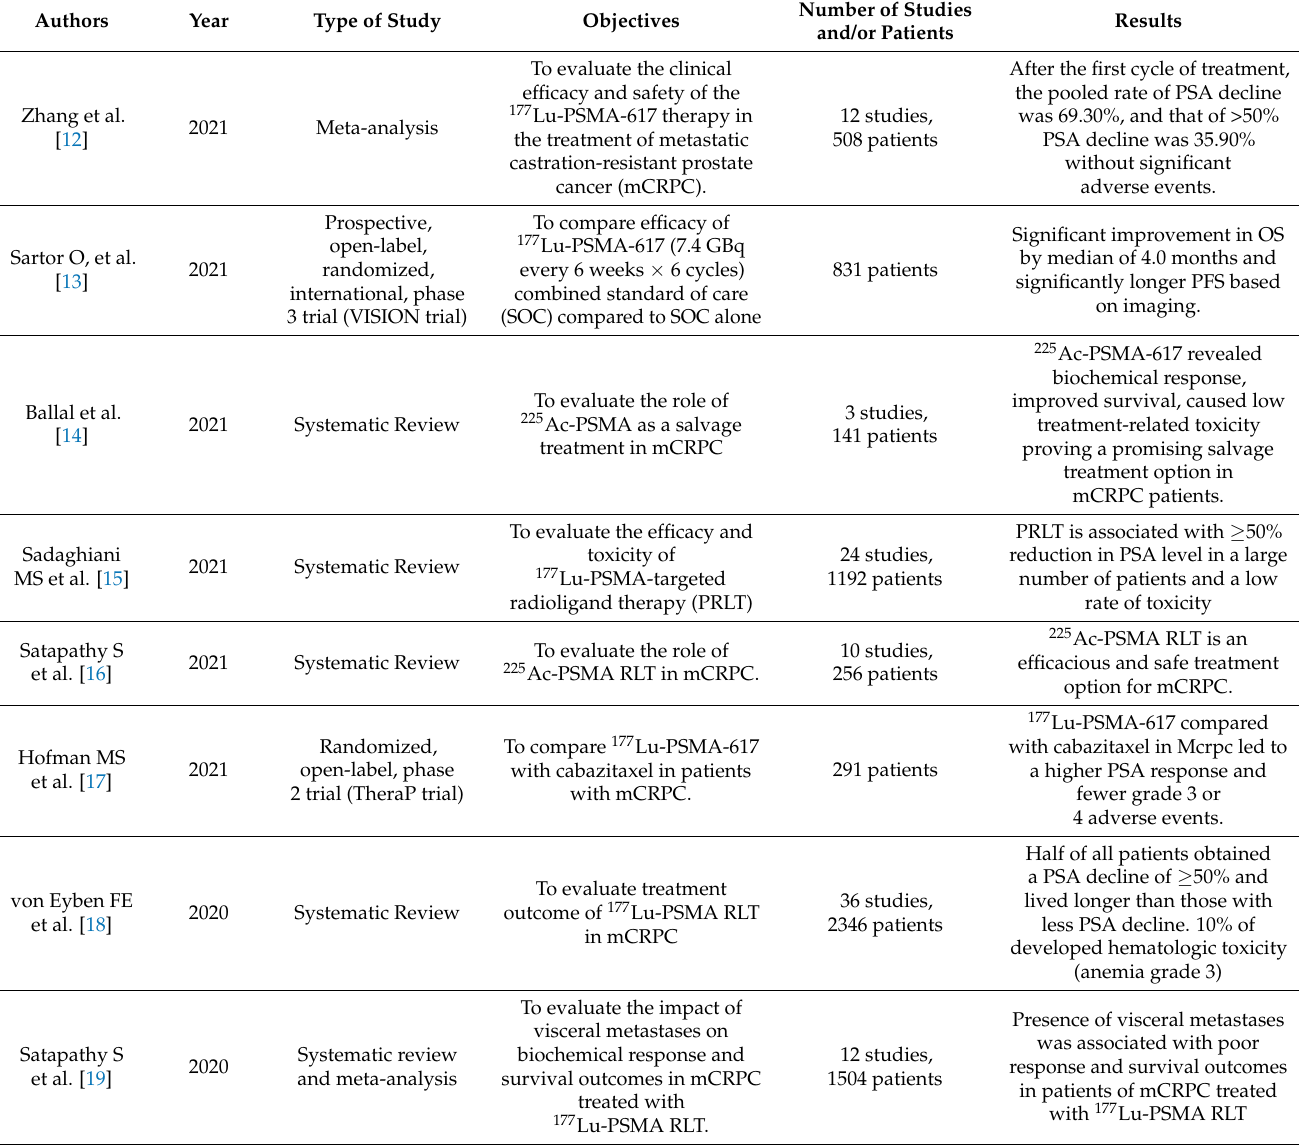
Table 2. Literature overview on PSMA-targeted radioligand therapy (RLT) in